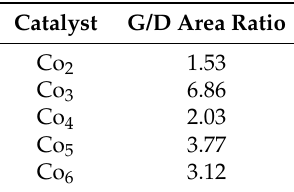
Figure 4. ( A ) Total carbon content after the CVD process. ( B ) Raman spectra of all CVD products arranged by the offset and ( C ) the RBM zone (150–350 cm − 1 ) zoom of all Raman spectra. Table 2. G-band and D-band ratio (G/D) of CVD products over MCM-41–Co. Catalyst